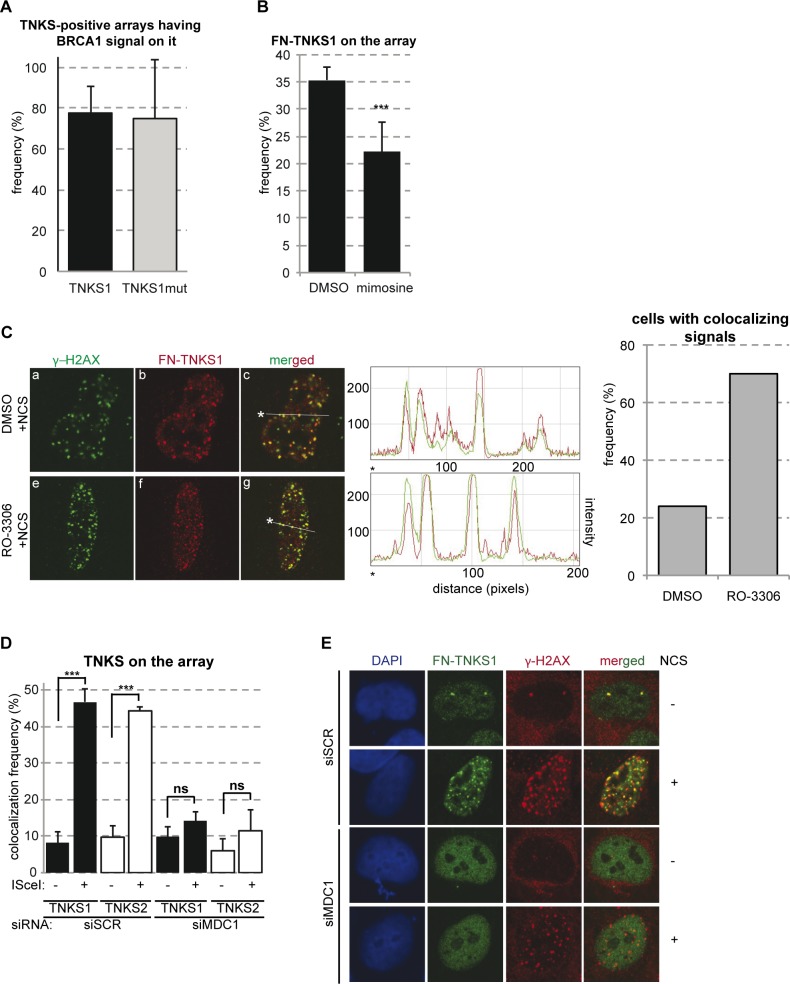
TNKSs are recruited to DSBs in a cell cycle dependent manner.(A) Quantification of the frequency of colocalization of TNKS and BRCA1 at pure DSBs in vivo. U2OS17 cells transfected with mCherry-lacR, FN-TNKS1 and ISce-I, and were co-stained with antibodies against flag and BRCA1. Percent of cells having TNKS1 signal at the lacO array also positive for BRCA1 was determined. Results from three independent experiments are shown with SD (N = 30). (B) Quantification of the frequency of TNKS1 recruitment to pure DBSs in control or G1 blocked cells. U2OS17 cells were transfected with mCherry-lacR, FN-TNKS1 and ISce-I. 20hours before fixation, cells were treated with mimosine to block the cell cycle in G1. Percent of cells with FN-TNKS1 signal on the lacO array was determined. Results from three independent experiments are shown with SD (N = 100). (C) TNKS1 is recruited to DSBs in vivo in a subset of cells. U2OS cells were transfected with FN-TNKS1, treated with NCS and immunostained with antibodies against flag and γ-H2AX. Cells were blocked in G2 phase by the CDK1 inhibitor RO-3306 on panels e-g. Frequency of cells showing a colocalizing signal for γ-H2AX and FN-TNKS increased from 24% (asynchronous cells) to 70% (G2 cells) as shown on the graph on the right. Colocalization was analyzed by plotting the intensity of the red/green signal against the distance along the white line on the merged image. The starting point is marked by a star. (D) MDC1 is required for TNKS recruitment to pure DSBs in vivo. U2OS17 cells were transfected with control or MDC1 targeted siRNAs. 24hours after siRNA treatment, cells were co-transfected with mCherry-lacR, FN-TNKS1 or MN-TNKS2 and ISce-I. The frequency of cells having TNKS1/2 signal on the array was determined, results of three independent experiments are shown with SD (N = 100). (E) MDC1 is required for TNKS foci formation. U2OS cells were transfected with control or MDC1-directed siRNAs. 48 hours later the cells were transfected with FN-TNKS1 and 24 hours later treated with 100ng/ml NCS. 6 hours after treatment cells were stained with antibodies against γ-H2AX and FN-TNKS. Representative confocal microscopy pictures are shown.